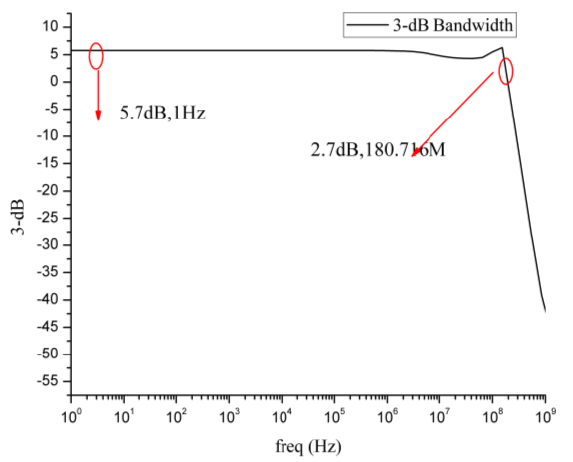
Figure 13. The 3-dB bandwidth of the linear amplifier.